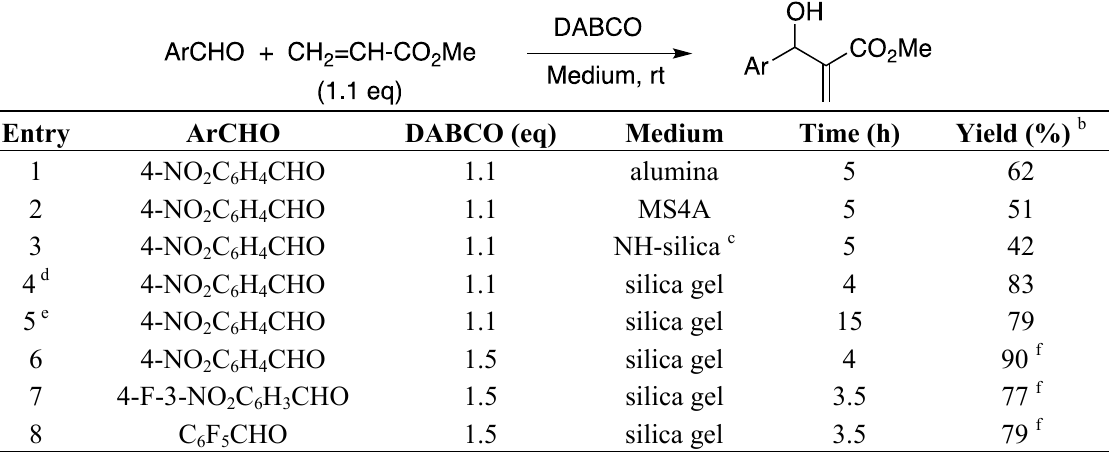
Table 7. The Morita-Baylis-Hillman reaction in various solid media a